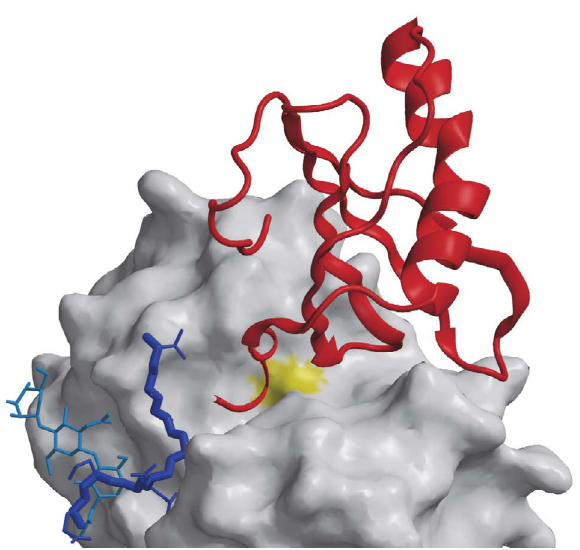
Figure 4. Cathepsin H - stefin A complex 131 (1NB5). Cathepsin H is shown as in the figure 3, whereas stefin A fold is shown as red ribbon.